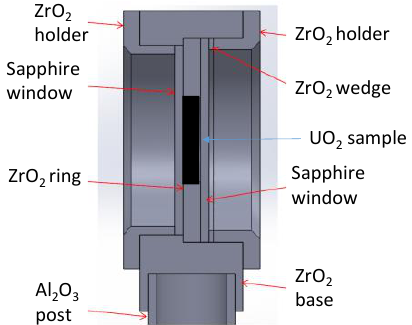
Fig. 3. Schematic of the sample holder assembly at the center of the vacuum chamber. A UO 2 disk, 8mm diameter and 1mm thick is visible in the sample holder.